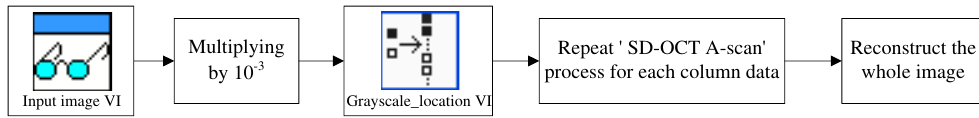
Fig. 6. The °owchart of the SD-OCT B-scan